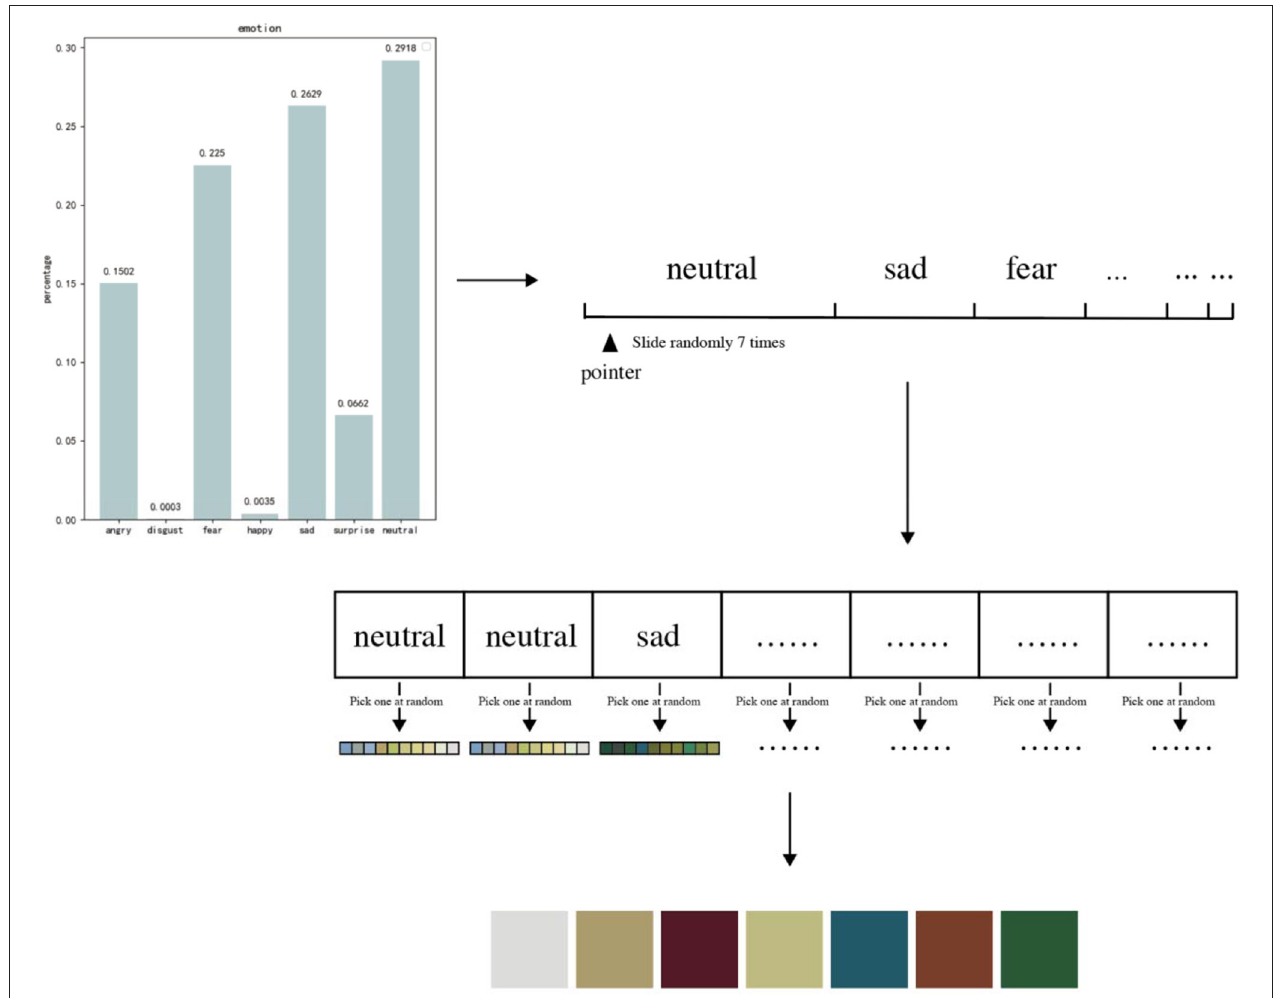
FIGURE 9 | Emotional palette